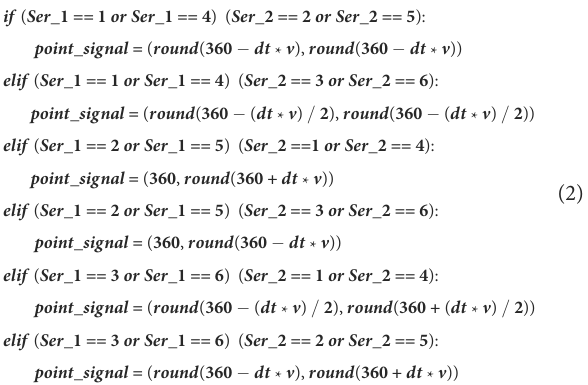
FIGURE 5 Flow chart of the machine vision algorithm for weeds and tomato plants classi fi